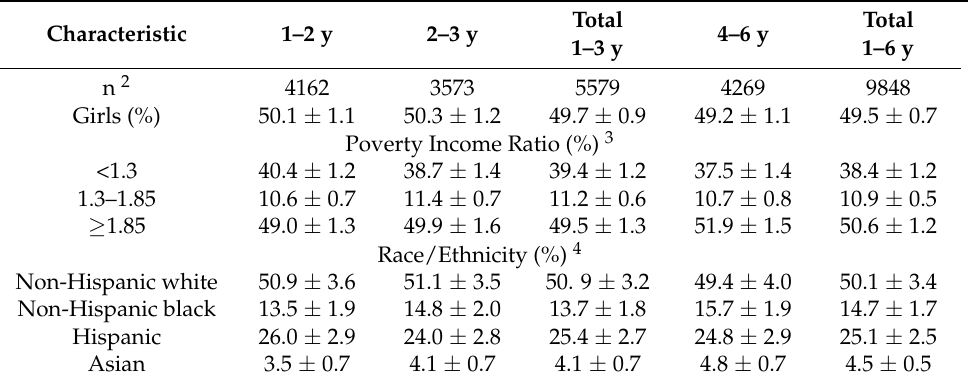
Table 1. Demographics of children 1–6 years by age group (NHANES 2001–2016) 1